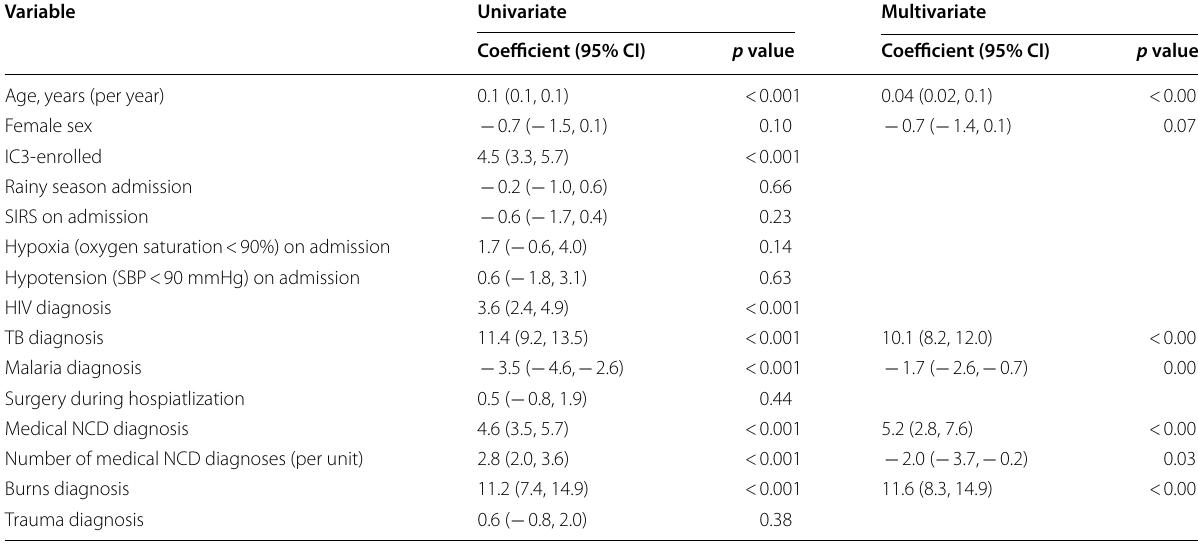
Linear regression findings for factors associated with patient length of stay, with both univariate and multivariate